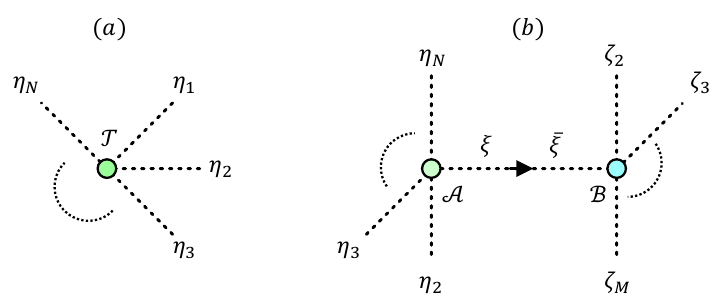
Figure 1 . Graphical representations of (a) Grassmann tensor in eq. (2.1) and (b) Grassmann contraction in eq. (2.2). The external lines specify uncontracted indices. The arrow in the internal line represents a contracted direction from ξ to ¯ ξ .